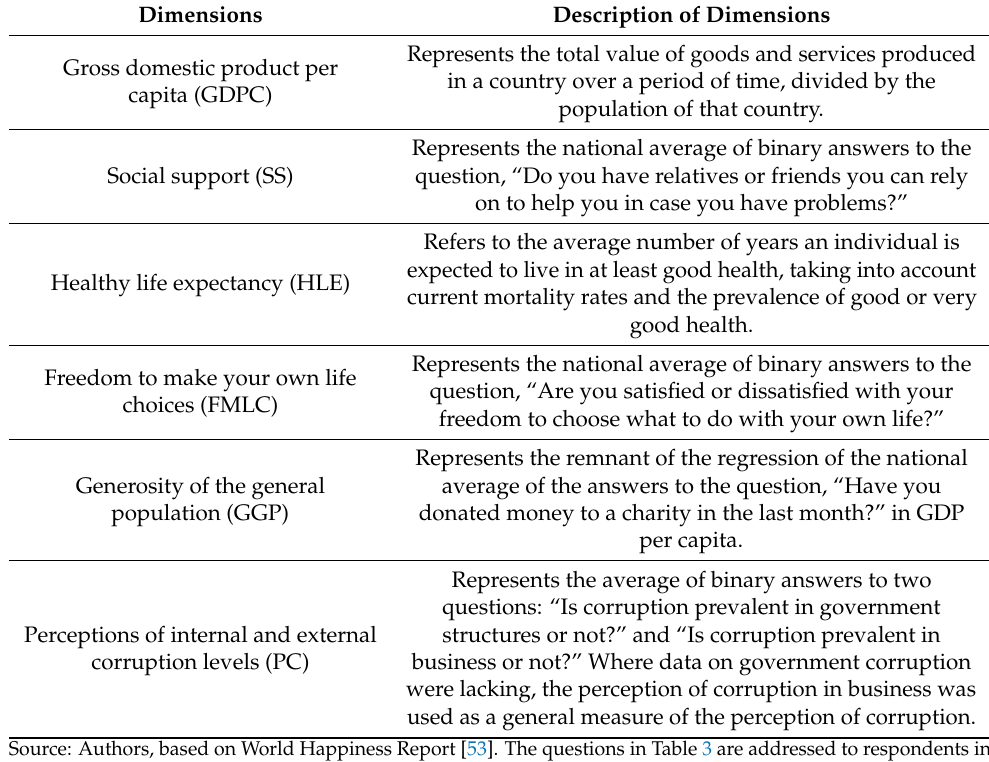
Table 3. World Happiness Index (WHI)